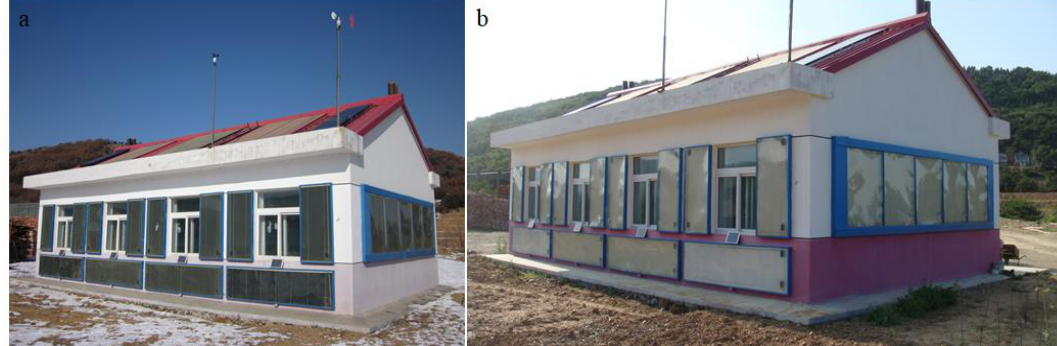
Figure 2. A photo of the full-scale experimental house ( a ) in winter ( b ) in summer. Table 2. Building information.